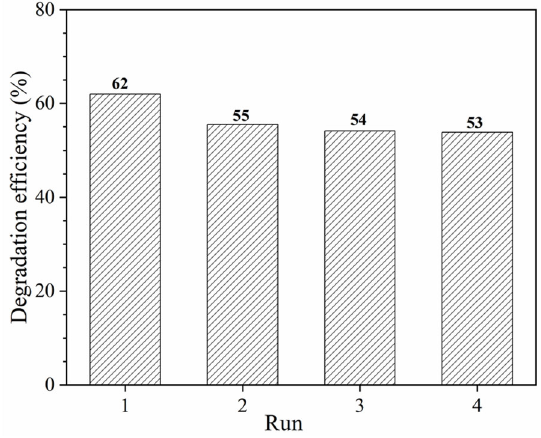
Figure 10. Recycling of POF NaOH /TiO 2 (m POF/TiO2 = 50 mg; c POF/TiO2 = 1 g/L, λ = 254 nm; [Phenol] 0 = 50 mg/L; pH = 6.7, t = 4 h).